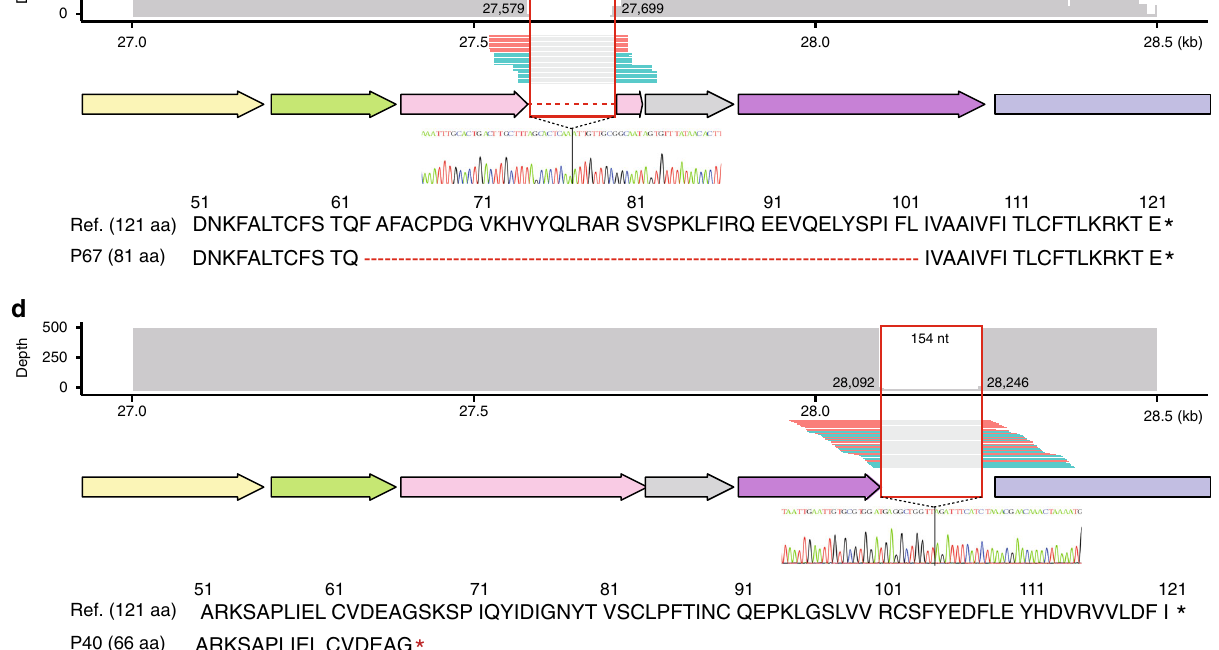
Fig. 4 The indels identi fi ed in the viral genomes sequenced in this study. a The loci of the indels and their distribution in the sequenced genomes. The arrow chart on top represents the protein-coding genes of SARS-CoV-2, and the vertical lines below mark the loci of the indels. b – d The read coverage of the three long fragment deletions in ORF6, ORF7a, and ORF8, respectively. Arrow charts in the middle represent the protein-coding genes, and the curves of read coverage and split reads supporting the deletions are displayed above. Forward and reverse mapping reads are in blue and red, respectively. Sanger sequencing results of corresponding PCR fragments are displayed below; resulting protein mutations are shown at the